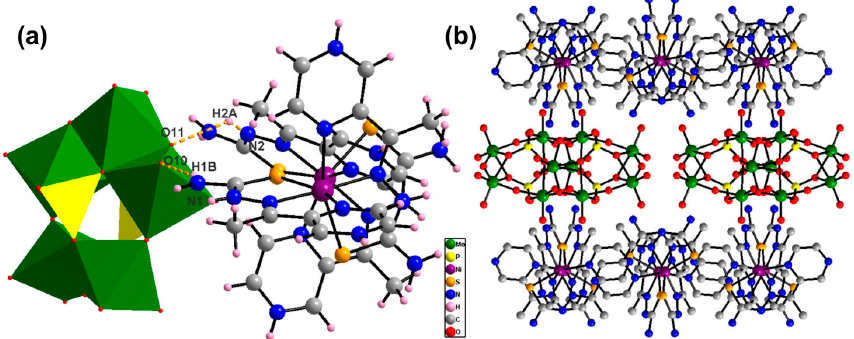
Figure 1. ( a ) Polyhedral/ ball-stick representations and ( b ) ball-stick representation of 3D network of 1